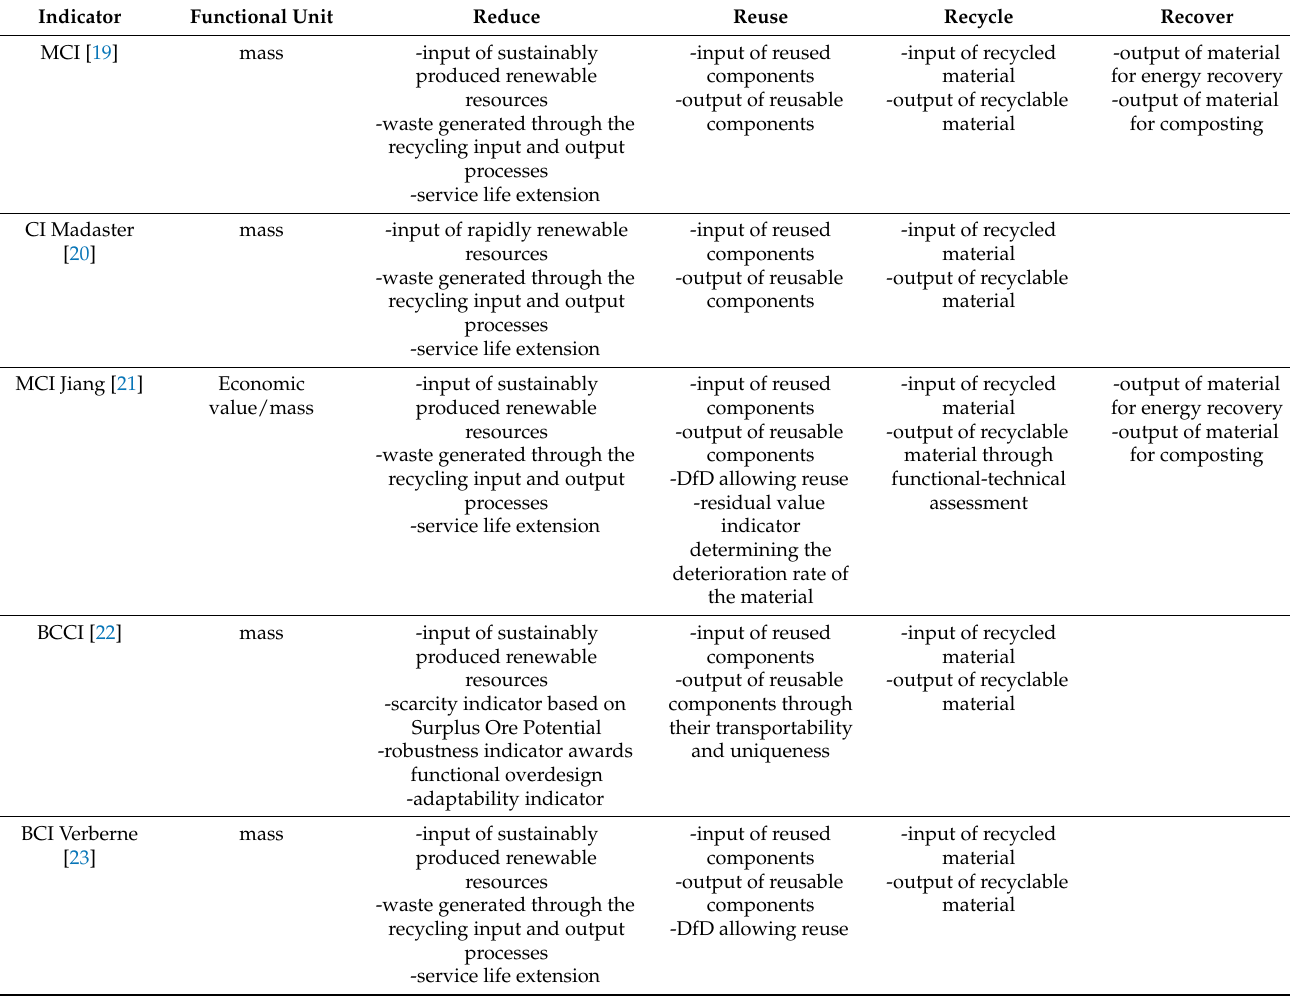
Table 1. Elaboration on what the different CIs actually